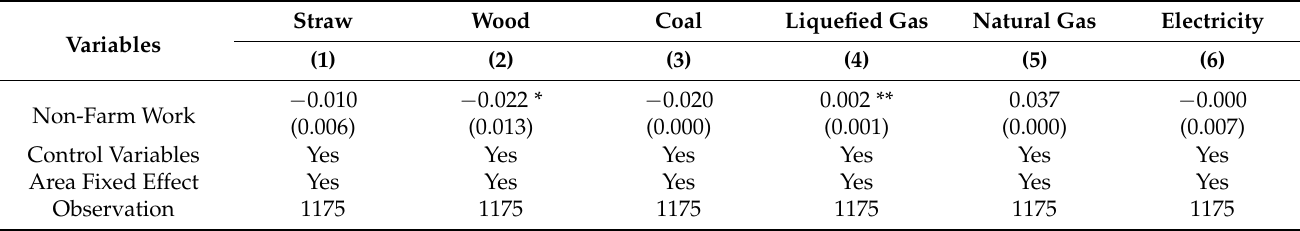
Table A4. Robustness Checks: Different Types of